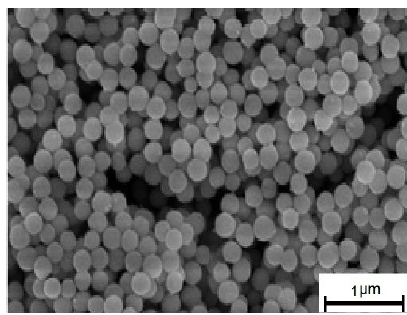
Figure 1. SEM scans from particles synthesized with generic sol-gel method.